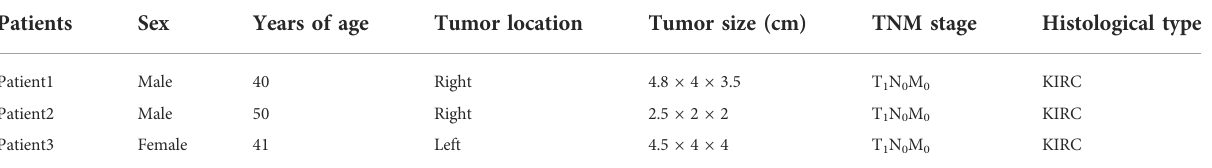
TABLE 1 The characteristics of patients for RT-qPCR.